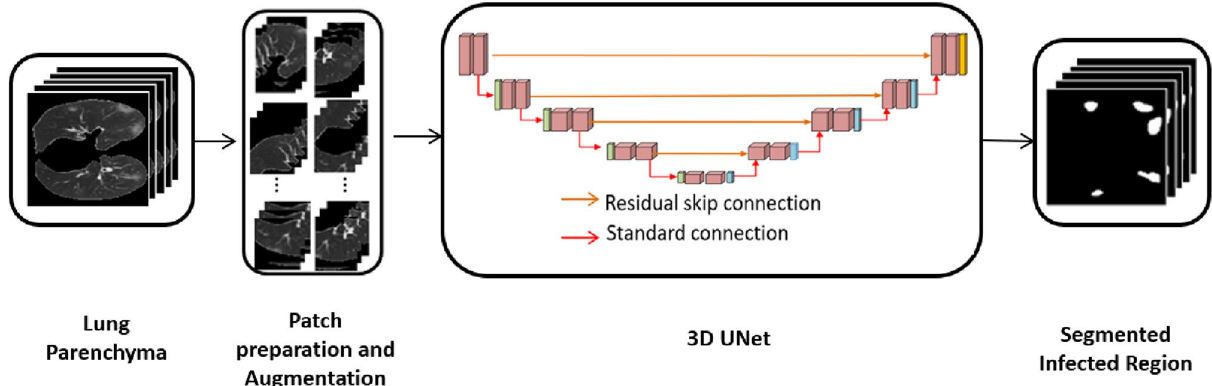
Figure 6. The proposed architecture for lung infected